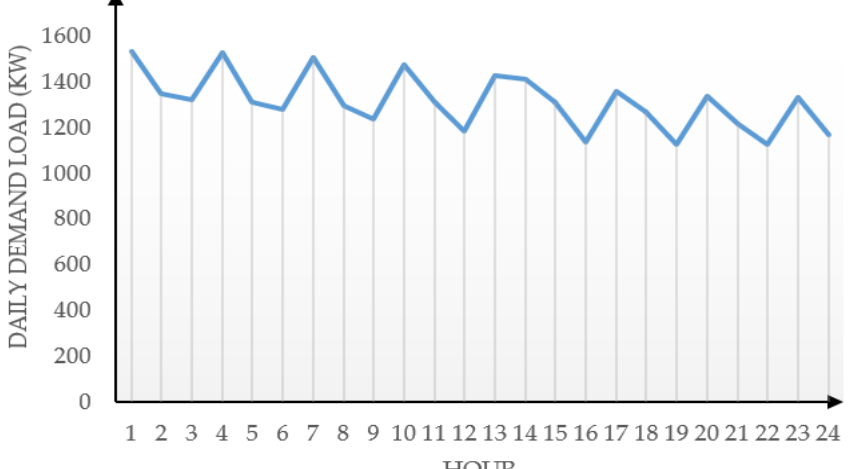
Figure 3. The daily maximum demand for a class-A customer in Ontario during the analyses period (2016).